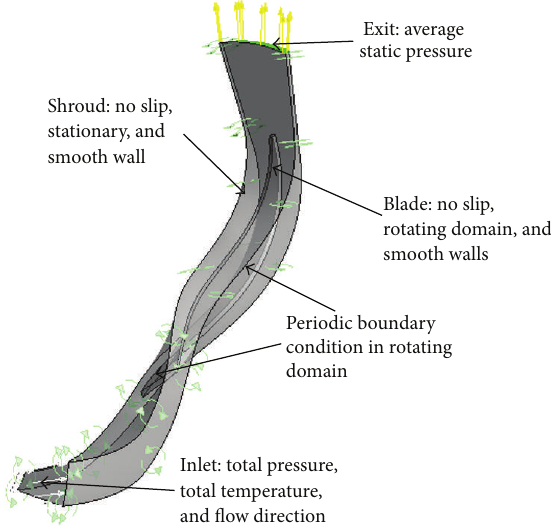
Figure 9: Boundary conditions applied to the